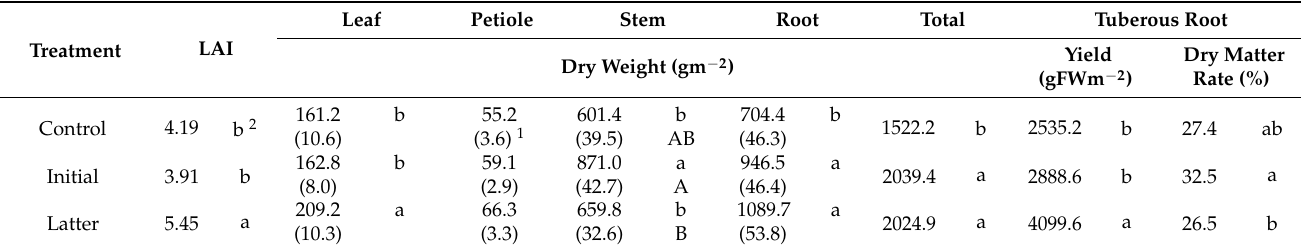
Table 1. LAI, dry weight, and dry matter distribution of plant parts and tuberous root parameter including flesh yield and root dry matter rate with different fertilization